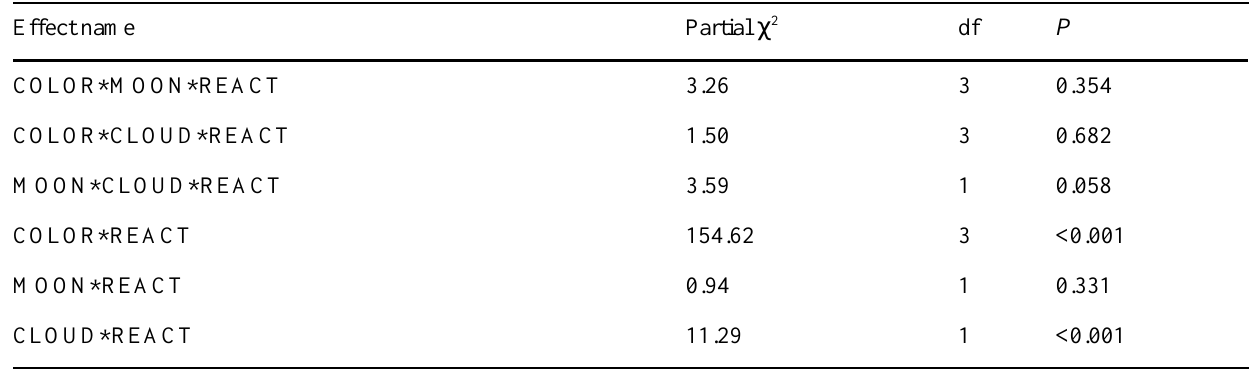
Table 4. Tests of all two-way and three-way partial associations involving reaction of the birds (REACT) in the fully saturated hierarchical log-linear model with generating class COLOR*MOON*CLOUD*